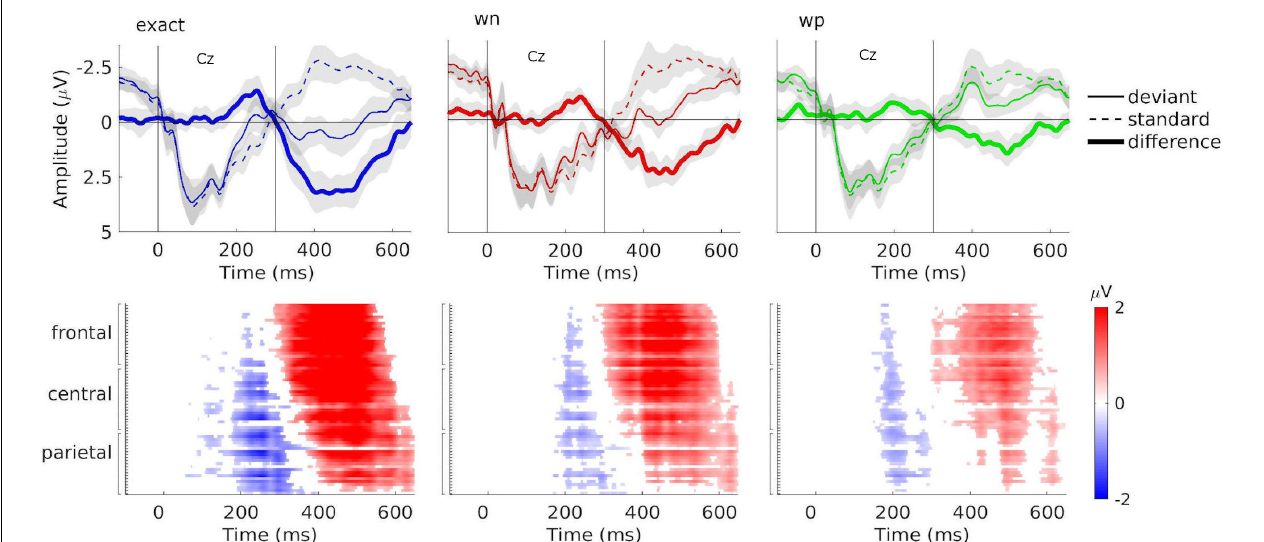
FIGURE 3 | Grand-averaged event-related potentials (ERPs), difference waveforms, and results of the cluster-based permutation test. Top: Grand-averaged ERPs at electrode Cz for combined train lengths 3, 6, and 12 in the exact-repetition condition (exact: blue), in the white-noise condition (wn: red), and in the wrong-pitch condition (wp: green). ERPs were elicited by standards (dashed line) and deviants (solid line). Difference waves of the grand-averaged ERPs (deviants minus standards) are shown as thick solid lines. Vertical solid lines indicate the pattern onset at 0 ms and the pattern offset at 300 ms. Bottom: Plots are illustrating significant differences (cluster p < 0.05) between ERPs to deviants and standards according to cluster-based permutation tests for combined train lengths 3, 6, and 12. Red and blue portions indicate time points/electrodes in which the ERPs to deviants are more positive and negative, respectively. Color brightness indicates the amplitude of the difference. White portions indicate time points/electrodes at which no significant differences were found. Negative deflections (blue) can be seen around 200–300 ms, and positive deflections (red) are found between 300 and 600 ms after the stimulus